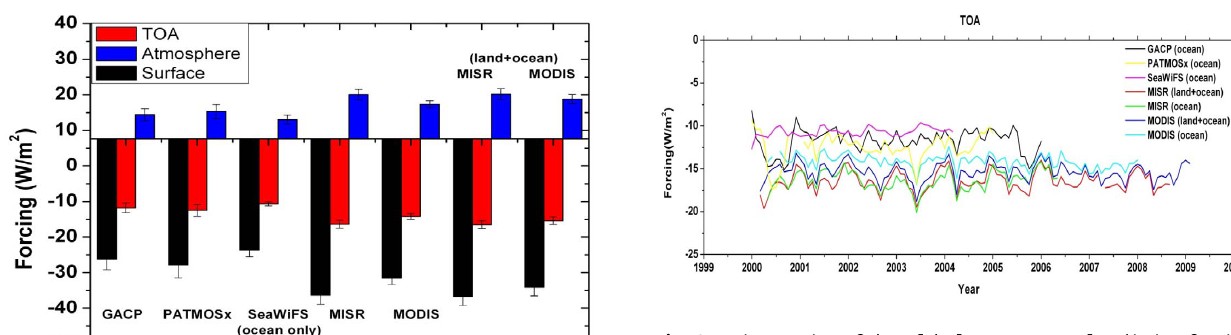
Fig. 6. Time series of the global mean aerosol radiative forcing Figure 6. Time series of the global mean aerosol radiative forcing at the top of the atmosphere at the top of the atmosphere based on different global aerosol op- based on different global aerosol optical depth products of the same aerosol optical properties tical depth products of the same aerosol optical properties from from AERONET.